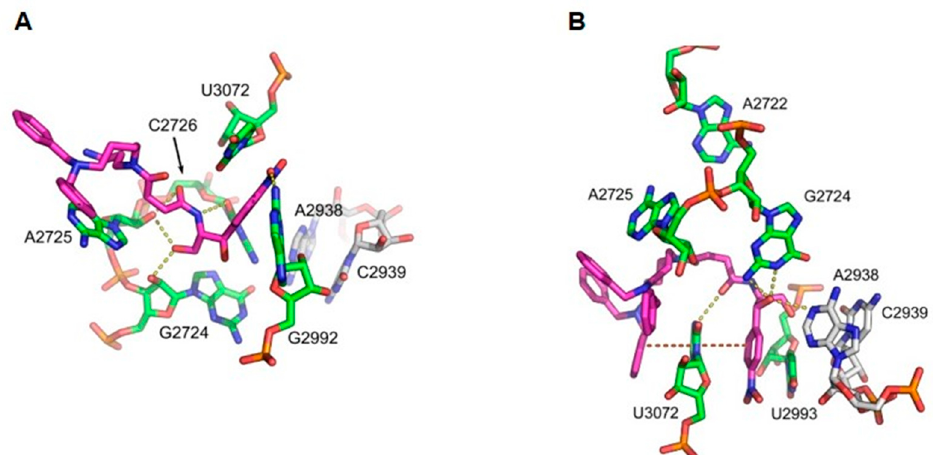
Figure 5. Molecular modeling of compounds binding mode in the vicinity of the catalytic center of hmLRS, derived from molecular dynamics (MD) simulations. Possible hydrogen bonds are shown with yellow bullets. For clarity only, relevant nucleotides of the environment are shown. Nucleotides A2938 and C2939 of the catalytic center are shown for orientation purposes in gray. ( A ) Compound 3 . Four possible hydrogen bonds stabilize compound 3 in the region, as shown in Table 5. ( B ) Compound 4 . Four possible hydrogen bonds (Table 5) as well as two stacking interactions stabilize compound 4 in the region. Note the hydrogen bond between N1 nitrogen of adenine in A2938 with a hydroxyl oxygen of compound 4 nearest to the CAM ring.